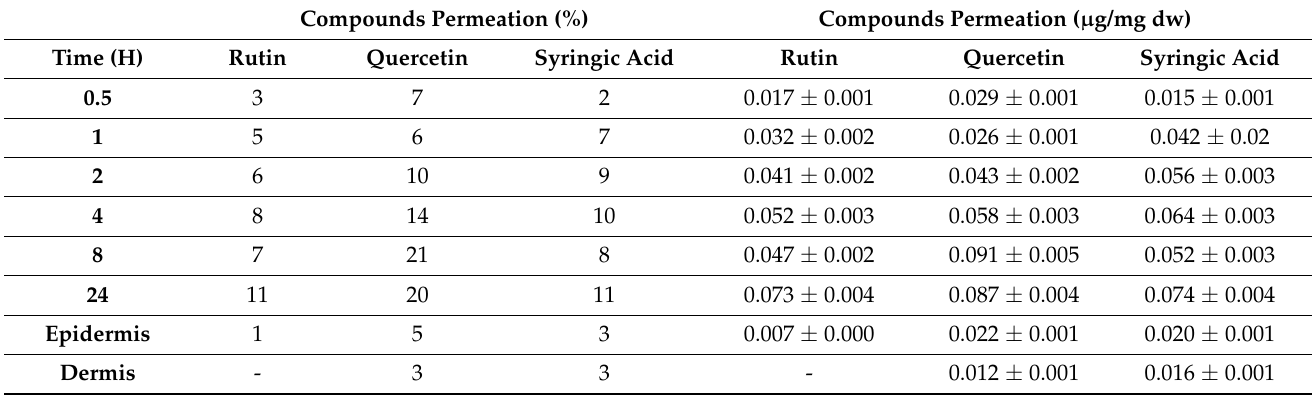
Table 6. Permeation of S. ramosissima phenolic compounds, concretely identified as rutin, quercetin and syringic acid. Values are expressed as compound’s permeation ± standard deviation ( n = 3). Compounds Permeation